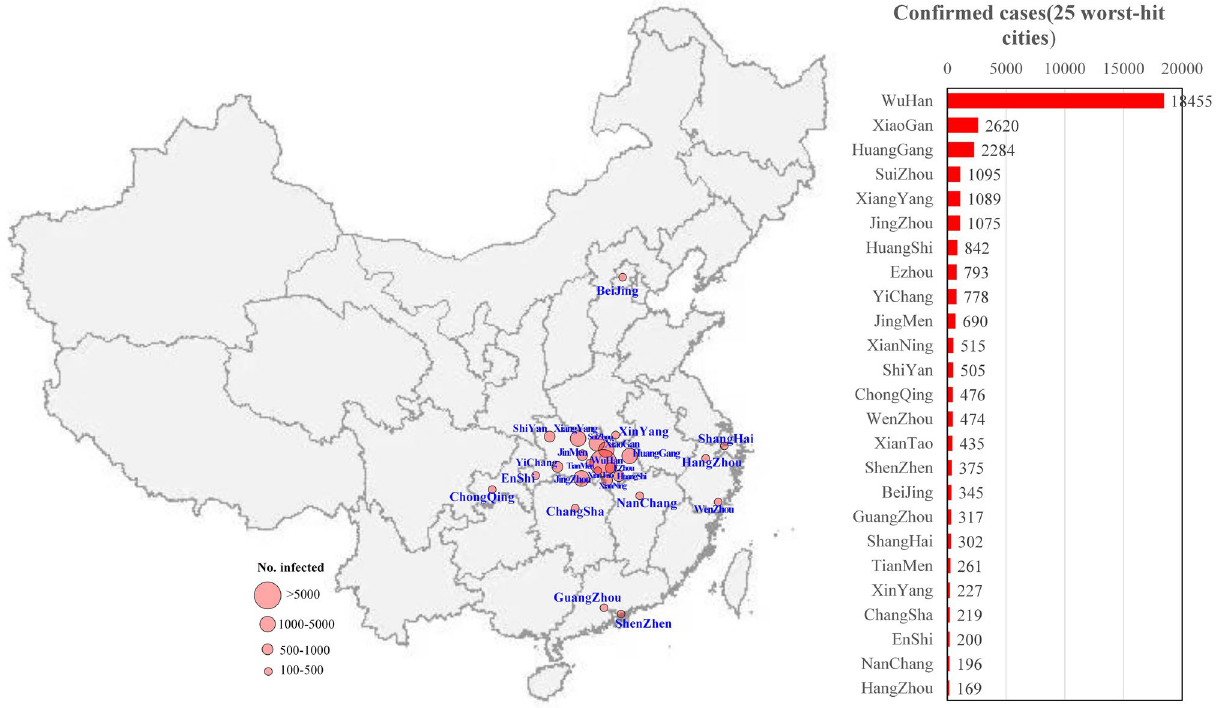
Figure 1. A geographic information map of the cumulative number of confirmed COVID-19 cases as of February 10, 2020 in the 25 worst-hit Chinese cities (the map was created using dituhui.com (www.dituh ui.com), and the right panel was created using Excel